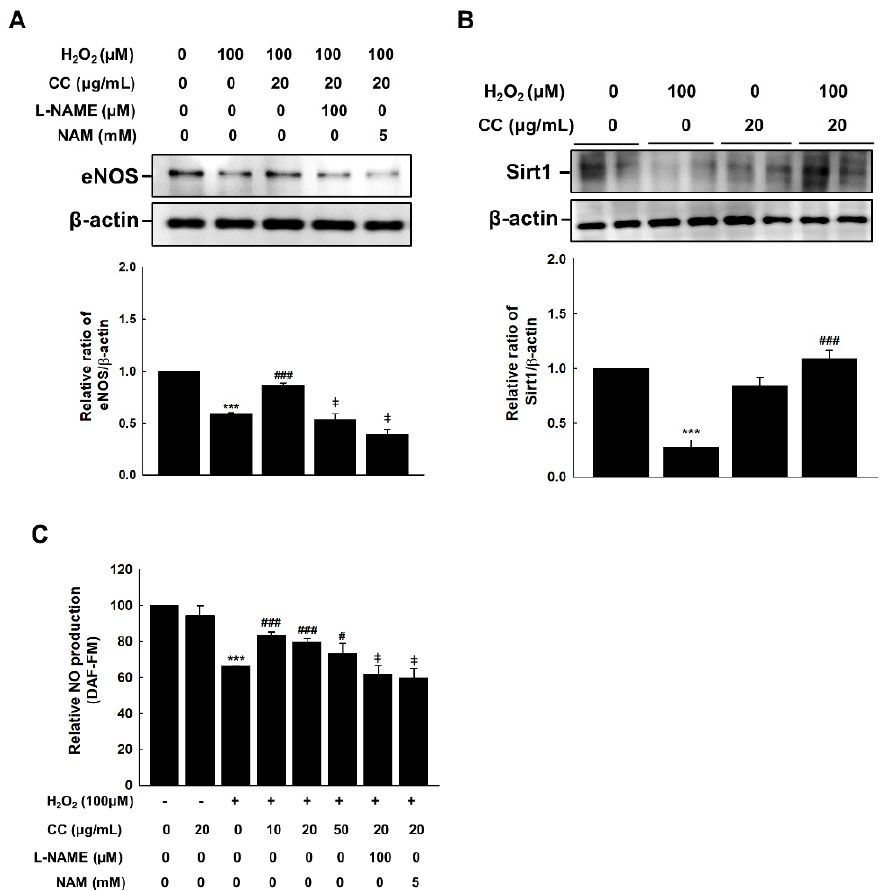
Figure 3. Chrysanthemum coronarium L. (CC) extract improves endothelial NO formation to combat senescence in HUVECs. ( A ) CC reversed the H 2 O 2 (100 µmol/L)-induced decrease of eNOS expression in H 2 O 2 -, L-NAME- (100 µM), and NAM- (5 mM) treated HUVECs. ( B ) Expression of Sirt1 in H 2 O 2 and H 2 O 2 + CC HUVECs ( C ) The relative ratios of DAF-FM fluorescence intensities indicate the degrees of endothelial NO formation in the H 2 O 2 -, L-NAME- (100 µM), and NAM- (5 mM) treated HUVECs. ***, p < 0.001, versus CB; #, p < 0.05, ###, p < 0.001, versus H 2 O 2 ; ǂ , p < 0.05, vs. H 2 O 2 + CC.